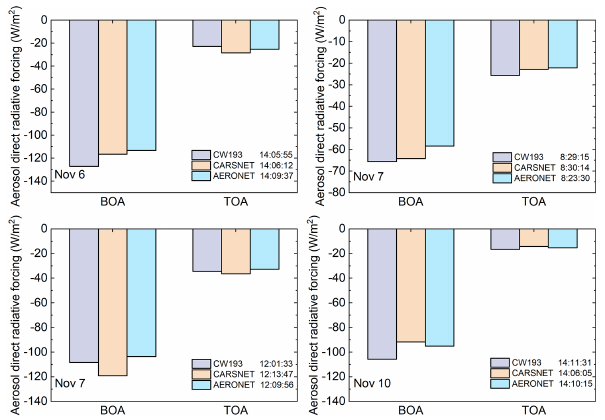
Figure 11. Comparison of the retrieved ADRF values from CW193, CARSNET and AERONET for four selected